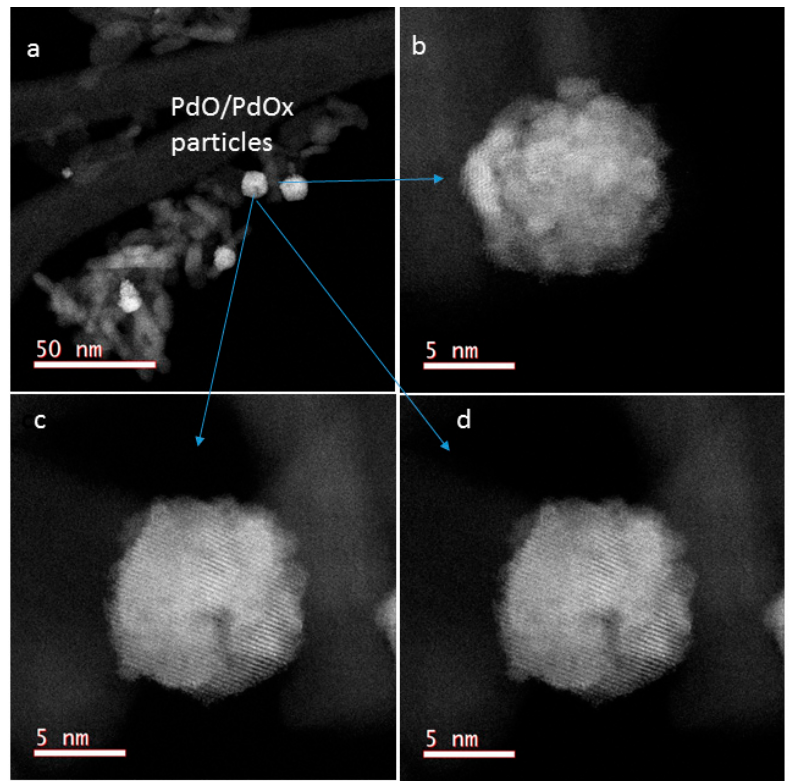
Figure 4. ( a ) HAADF-STEM images of PdO/PdO x particles; ( b – d ) are magnification of the same particles; PdO/PdO x crystals are nanoparticles of size 5–10 nm.